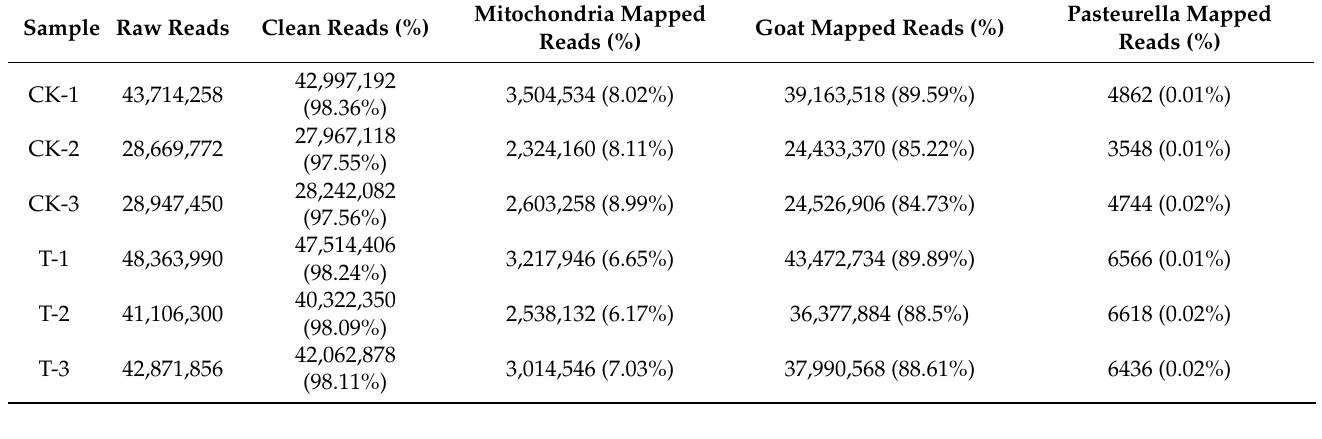
Table 1. ATAC-seq data statistics.